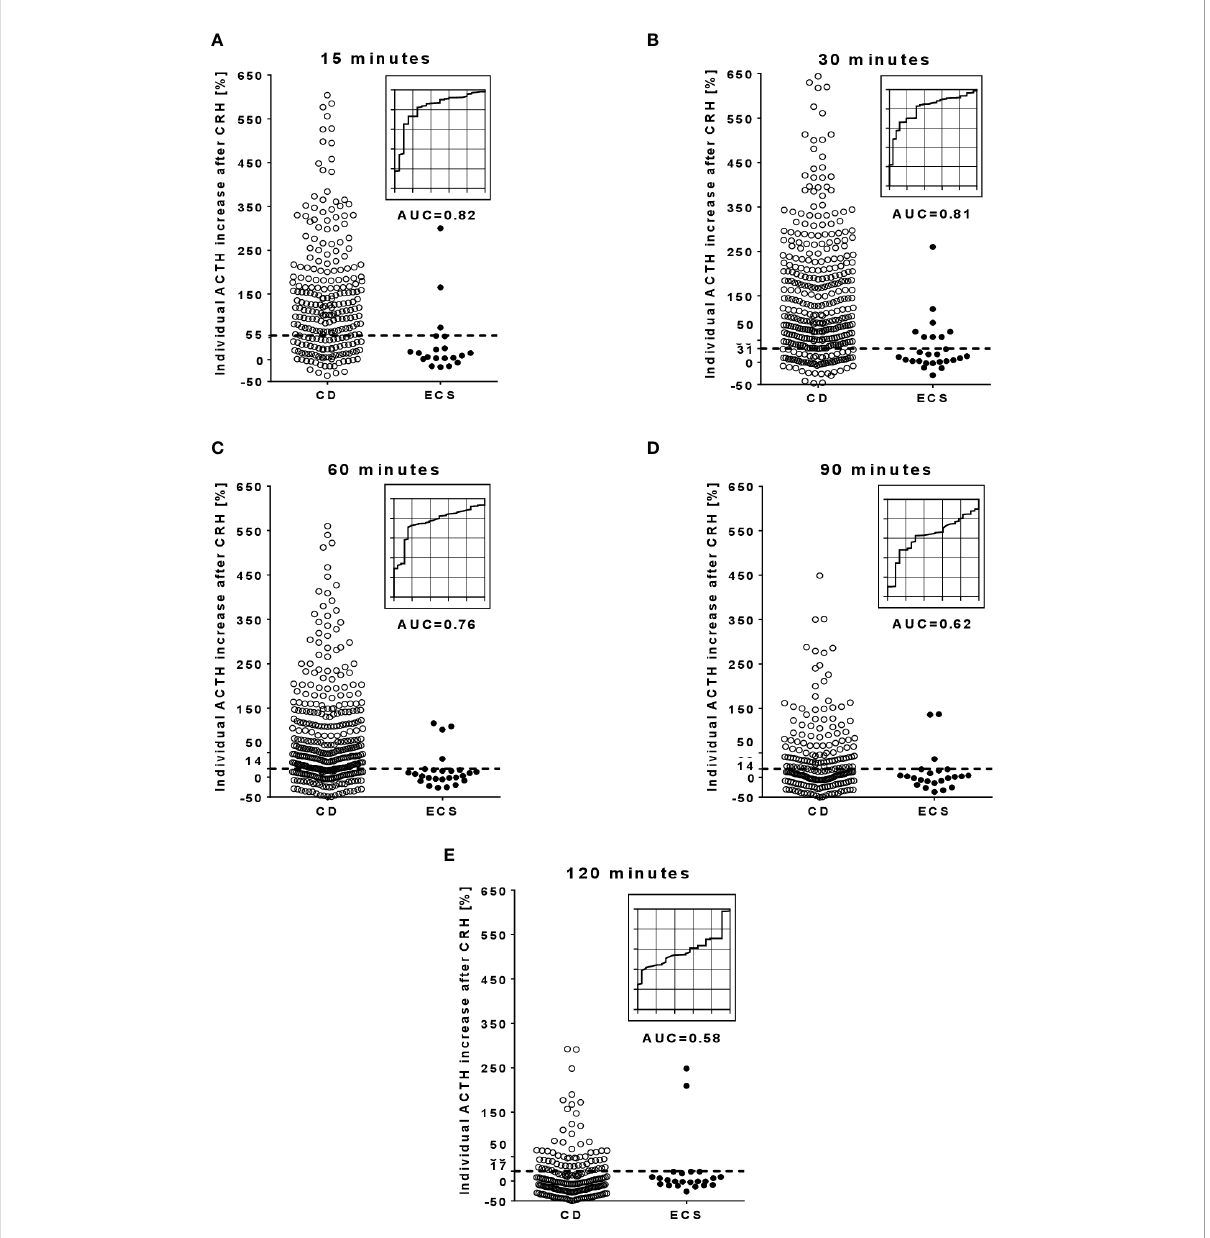
FIGURE 2 Individual %-increase of ACTH after CRH and corresponding ROC curves at different time points during the CRH stimulation test. ( A , at 15 minutes; B , at 30 minutes; C , at 60 minutes; D , at 90 minutes; E , at 120 minutes). The dotted lines in the scatter plots illustrate the optimal cut- off for the post-CRH %-increase of ACTH. Few outlier results are not reported in the scatter plots: 13 CD patients at 15 minutes, 20 CD patients at 30 minutes, 11 CD patients at 60 minutes, and 3 CD patients at 90 minutes. ACTH, adrenocorticotropin; AUC, area under the curve; CD, Cushing ’ s disease; CRH, corticotropin-releasing hormone; ECS, ectopic Cushing ’ s syndrome; ROC, receiver operator